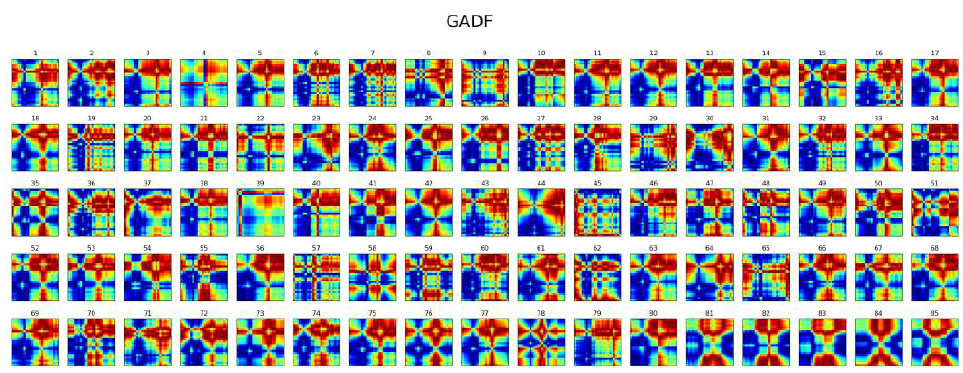
Figure 12. Time series image datasets recorded for 85 days (GADF).